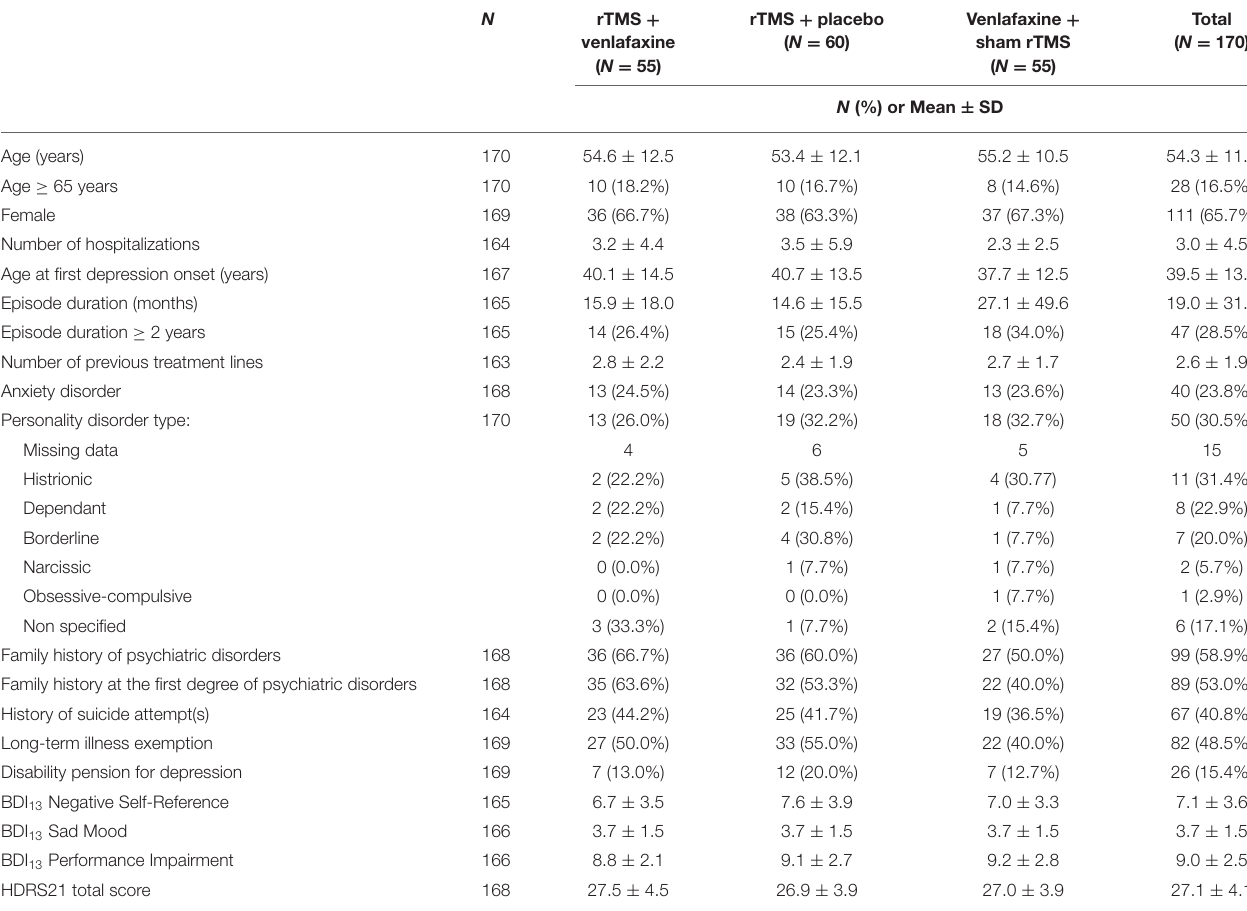
TABLE 1 | Clinical and demographical characteristics of the whole sample ( N = 170) at